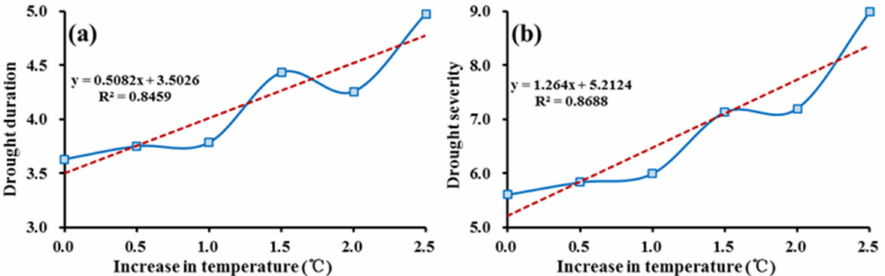
Figure 11. Sensitivity on average ( a ) drought duration ( DD ) and ( b ) severity ( DS ) due to temperature change in the YRSR.